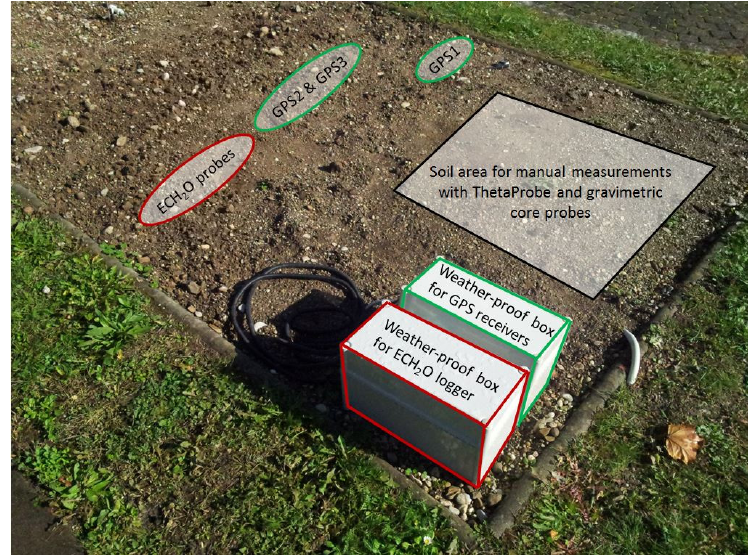
Figure 1. Soil measurement field at the DWD test site in Munich. The locations of GPS1, GPS2 and GPS3 as well as the locations of the other soil moisture measurements (ECH 2 O, ThetaProbe and gravimetric core probes) are marked.